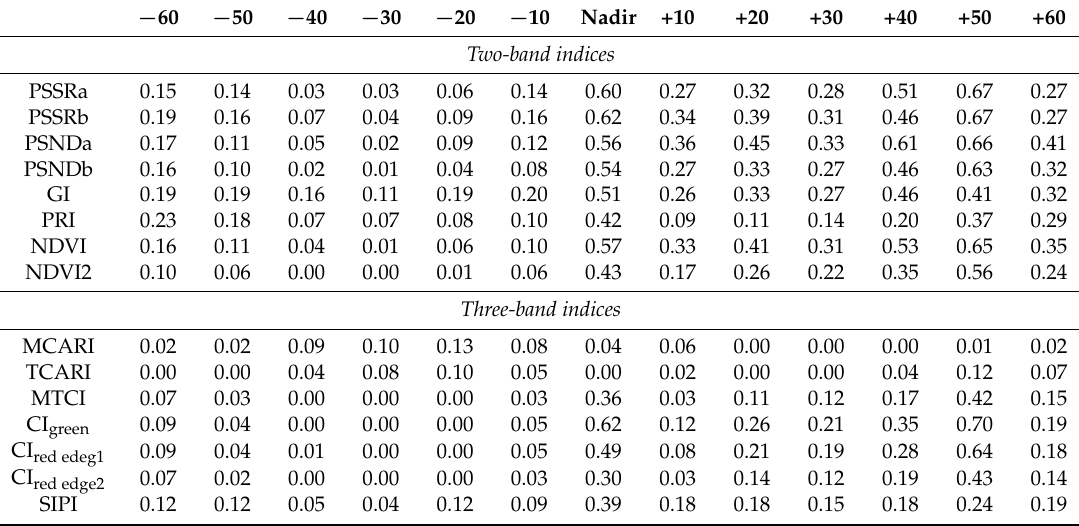
Table 2. Coefficients of determination (R 2 ) between published spectral indices and leaf Chl content in the upper-layer of wheat canopy at different viewing angles.